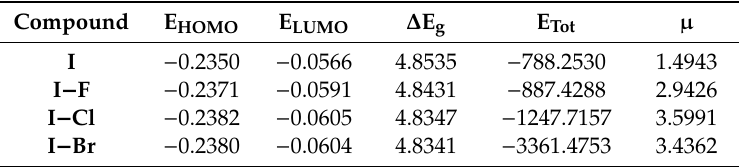
Table 7. Molecular orbital energies (E HOMO and E LUMO , hartree), gap energies ( ∆ E g , eV), total energy (E Tot , hartree), and dipole moment (Debyes) of I , I − F, I − Cl , and I − Br compounds calculated at PBE1PBE/6-311G(d,p) theory level.